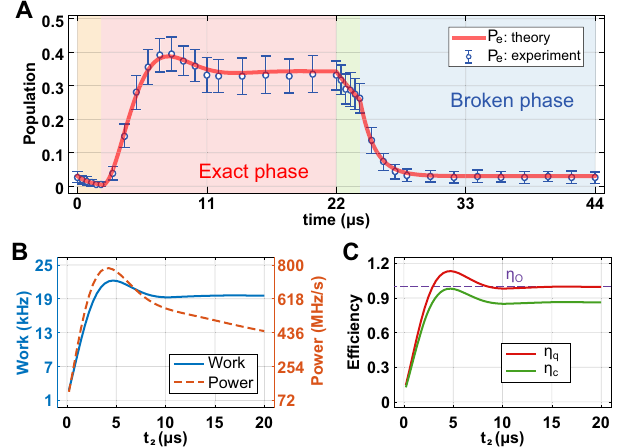
Fig.3|TheOttocyclewiththeisochoricheatingprocessintheexactphaseand the isochoric cooling process in the broken phase. A Time evolution of the populationintheexcitedstate ∣ e i whenthesecondstroke(isochoricheating)isinthe exact phase with oscillatory dynamics and the fourth stroke (isochoric cooling) is in the broken phase with non-oscillatory dynamics. The red solid curve is obtained by simulating the masterequationand thecircles and the errorbars respectively denote the average and standard deviation of 10,000 measurements. Regions with different colorscorrespondtodifferentstrokesof theOttocycle,withtheorange,pink,green, and blue corresponding to the fi rst (adiabatic compression), second (isochoric heating), third (adiabatic expansion), and fourth (isochoric cooling) strokes, respec- tively. The fi rst (orange) and the third (green) strokes are implemented by up- and down-scanning the detuning Δ between Δ min = 2 π =0 kHz, and Δ max = 2 π =10 kHz, respectively,withconstant Ω and γ eff .Thesecond(pink)andthefourth(blue)strokes are implemented by rapidly increasing and decreasing Ω / γ eff with constant detuning. Weused{ Ω /2 π =25kHz, γ eff =860kHz},and{ Ω /2 π =25kHz, γ eff =140kHz}forthe fi rst and third strokes, respectively, and f Ω = 2 π =90kHz, γ eff =500kHz, Δ = Δ max g and f Ω = 2 π =25kHz, γ eff =860kHz, Δ = Δ min g for the second and fourth strokes, respec- tively. B Thenetworkandoutputpower,and( C )theef fi ciencies η c and η q asfunctions ofthesecondstrokeexecutiontime t 2 ( ≤ 20 μ s),whiletheexecutiontimesoftheother strokesarekept fi xed.In( C ),thehorizontaldashedlinerepresentstheef fi ciency η O =1 of the ideal Otto